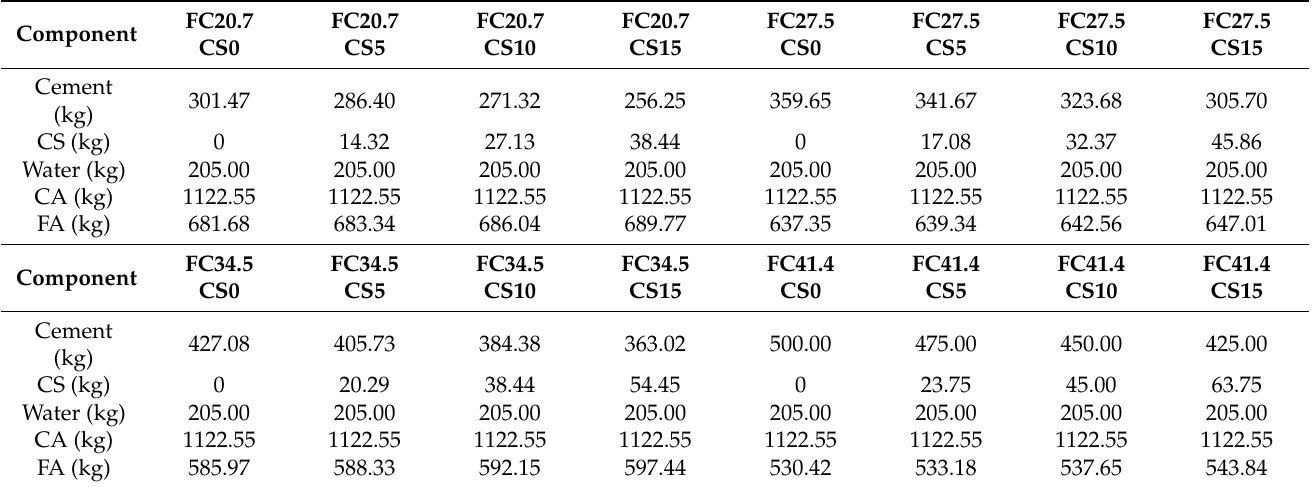
Table 3. Concrete mix proportions on a per cubic meter